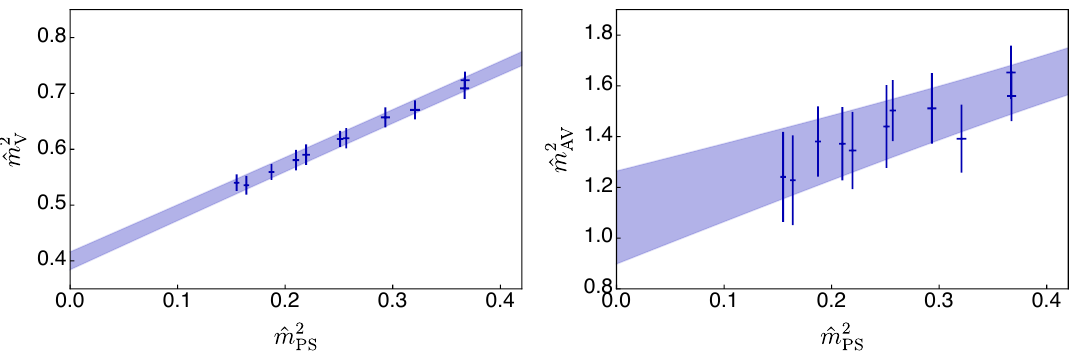
Figure 13. Masses squared in the continuum limit | subtracting lattice artefacts due to a (cid:12)nite lattice spacing (see table 9) | as a function of the pseudoscalar mass ^ m 2 statistical uncertainties. The global (cid:12)t results are denoted by shaded bands whose widths indicate the statistical errors.